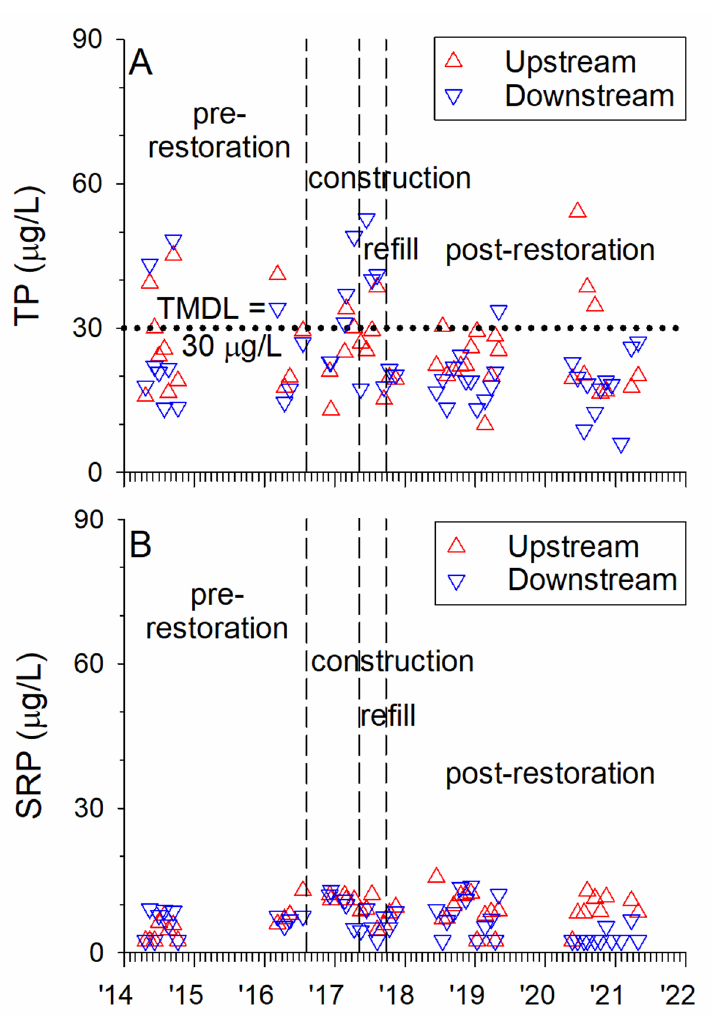
Figure 7. Bear Creek TP ( A ) and SRP ( B ) site concentrations over 2014–2021 monitoring period, divided into restoration phases. Reference line at 30 μg/L represents TP target goal set by the Bear Lake TMDL [26]. Note the log scale y -axis.